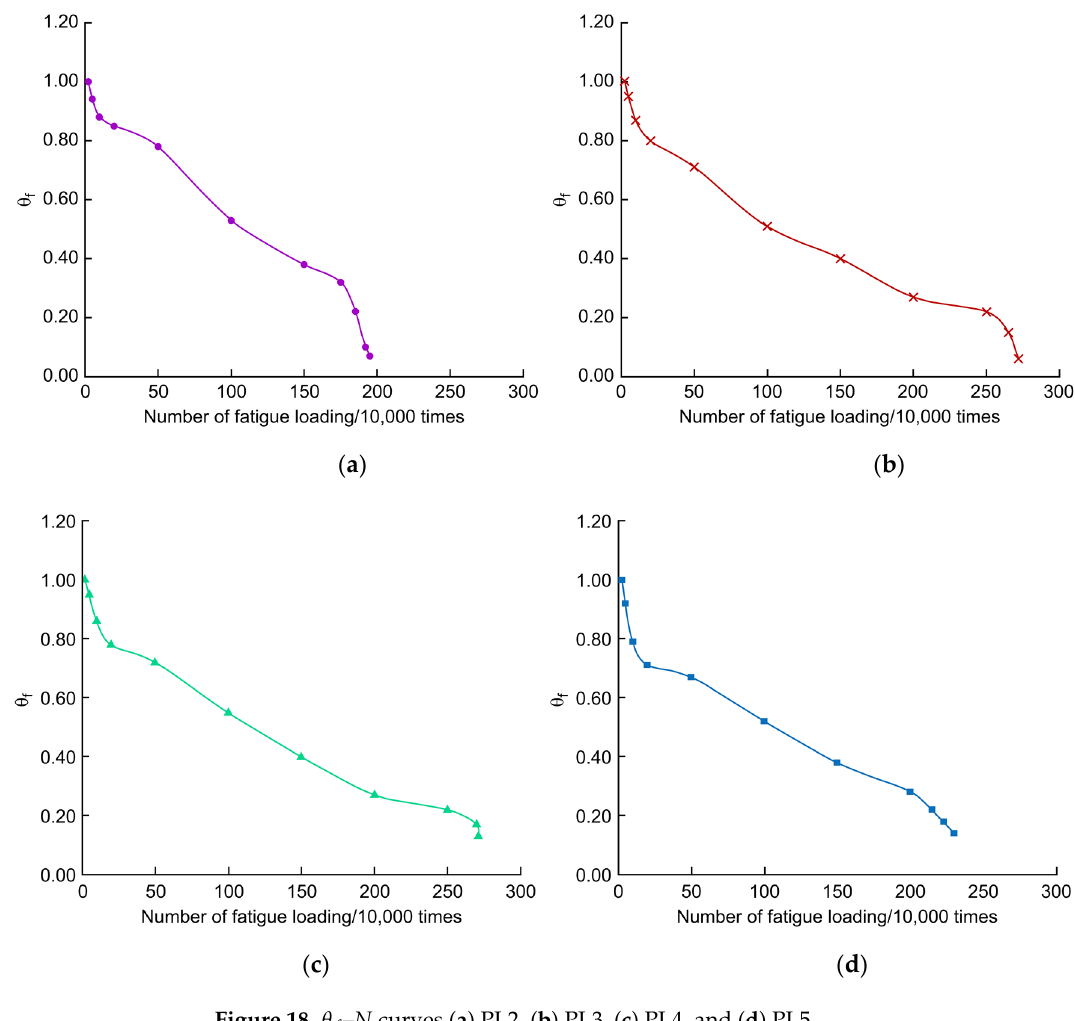
Figure 18. 𝜃 (cid:3033) – N curves ( a ) PL2, ( b ) PL3, ( c ) PL4, and ( d )